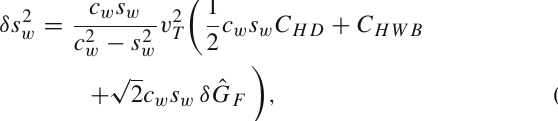
Higgsstrahlung cross section at different centre-of-mass energies in terms of the mixing angles, when M X = 1TeV. For the sake of comparison, we have also computed them for the larger centre-of-mass energy √ s = 500GeV